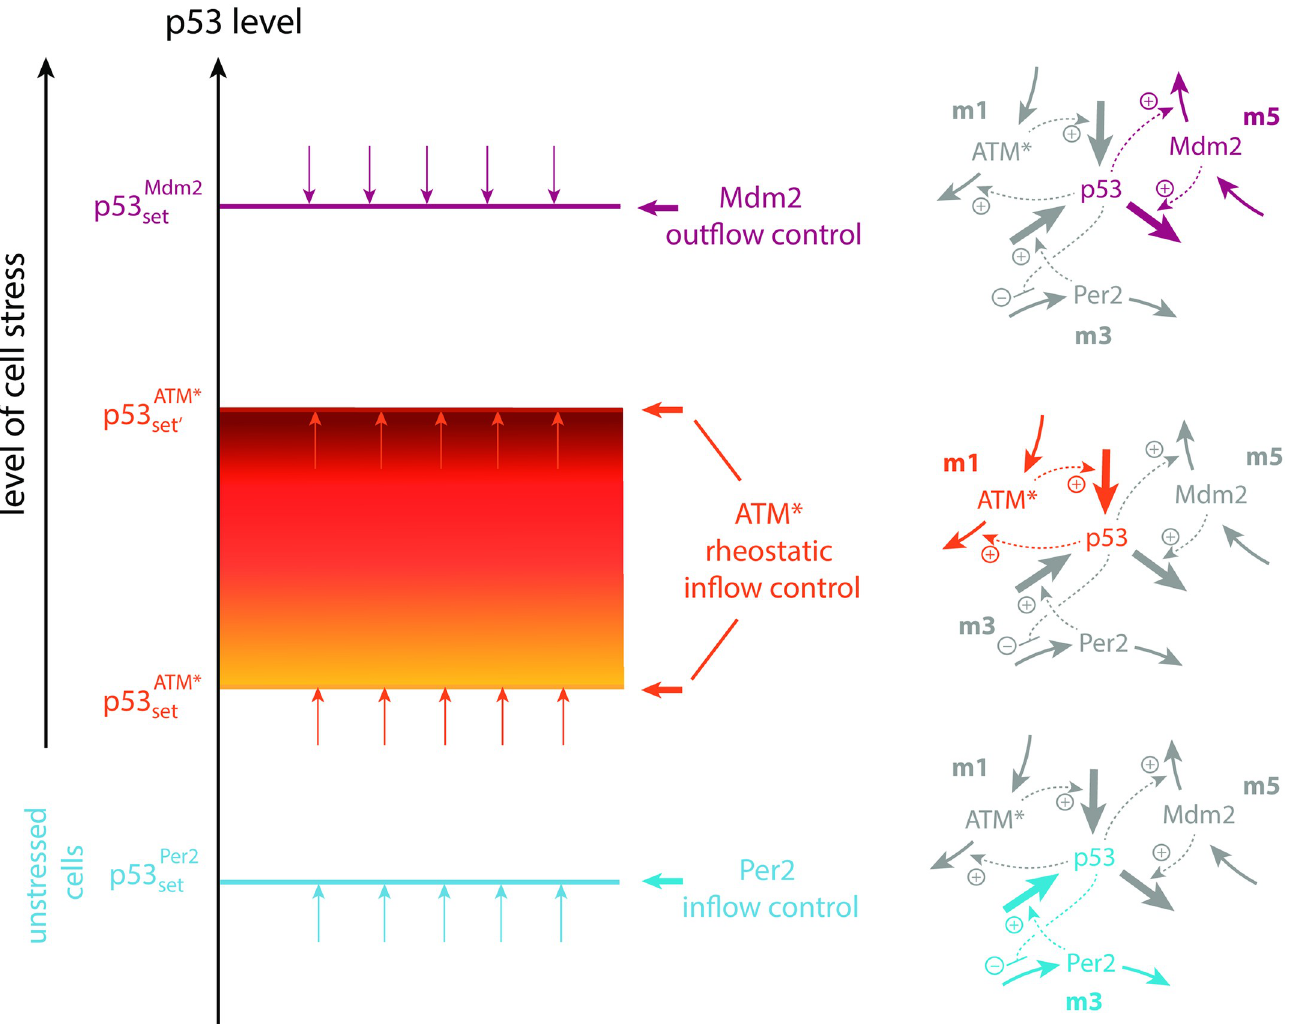
Fig 7. Hierarchical regulation of p53 by Per2, ATM � , and Mdm2 in unstressed and stressed cells. Outlined in blue is the regulation of p53 in unstressed cells, where Per2, acting as an inflow regulator, keeps p53 at a low “preconditioning” level [45]). In the presence of cell stress ATM � is upregulated (outlined in orange). The rheostatic set-point [57] of this inflow controller increases with increasing cell stress until control by Mdm2 at higher stress levels (outlined in purple) opposes a further increase of the p53 level. Schemes to the right show the color-coded active control loops and the grayed inactive